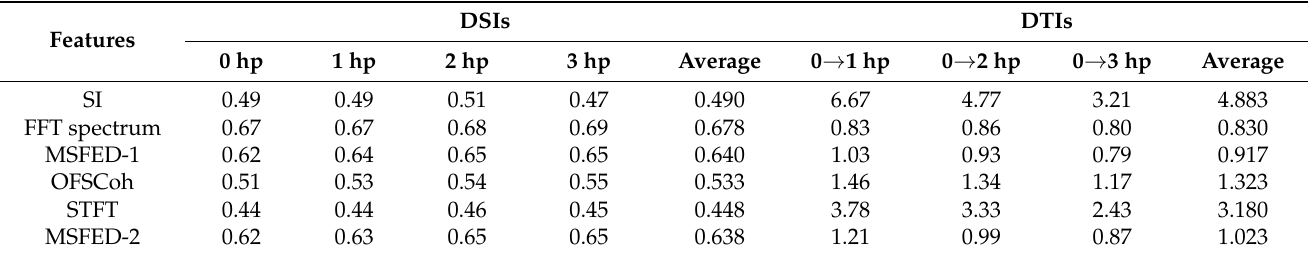
Table 10. The DTIs of six features on the gearbox dataset and the bearing